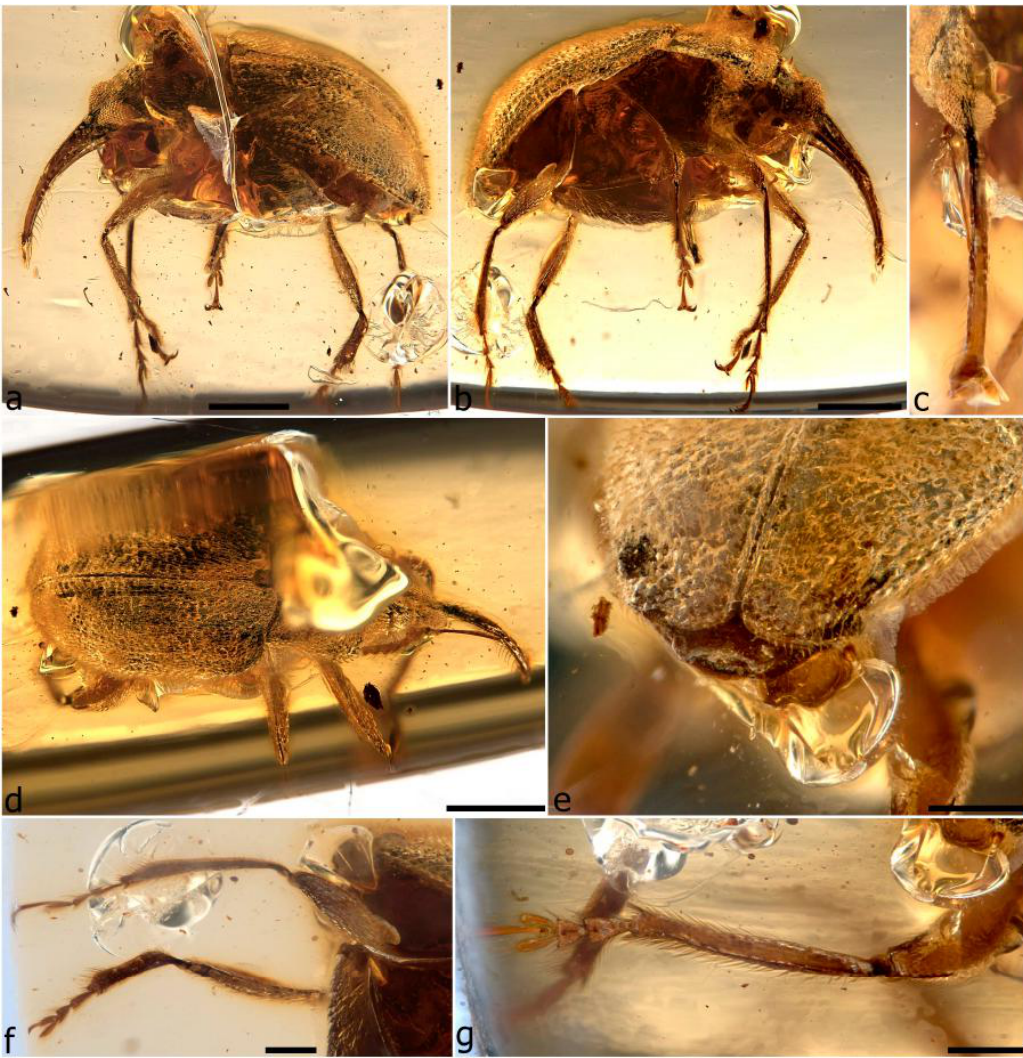
Figure 81. Leptopezus barbatus sp. n., holotype. Habitus, left lateral ( a ); habitus, right lateral ( b ); head, dorsal ( c ); habitus, dorsal ( d ); apices of elytra showing exposed tergite ( e ); hindlegs, lateral ( f ); right hindleg, posterior ( g ). Scale bars: 0.5 mm (a,b,d); 0.2 mm (e–g).